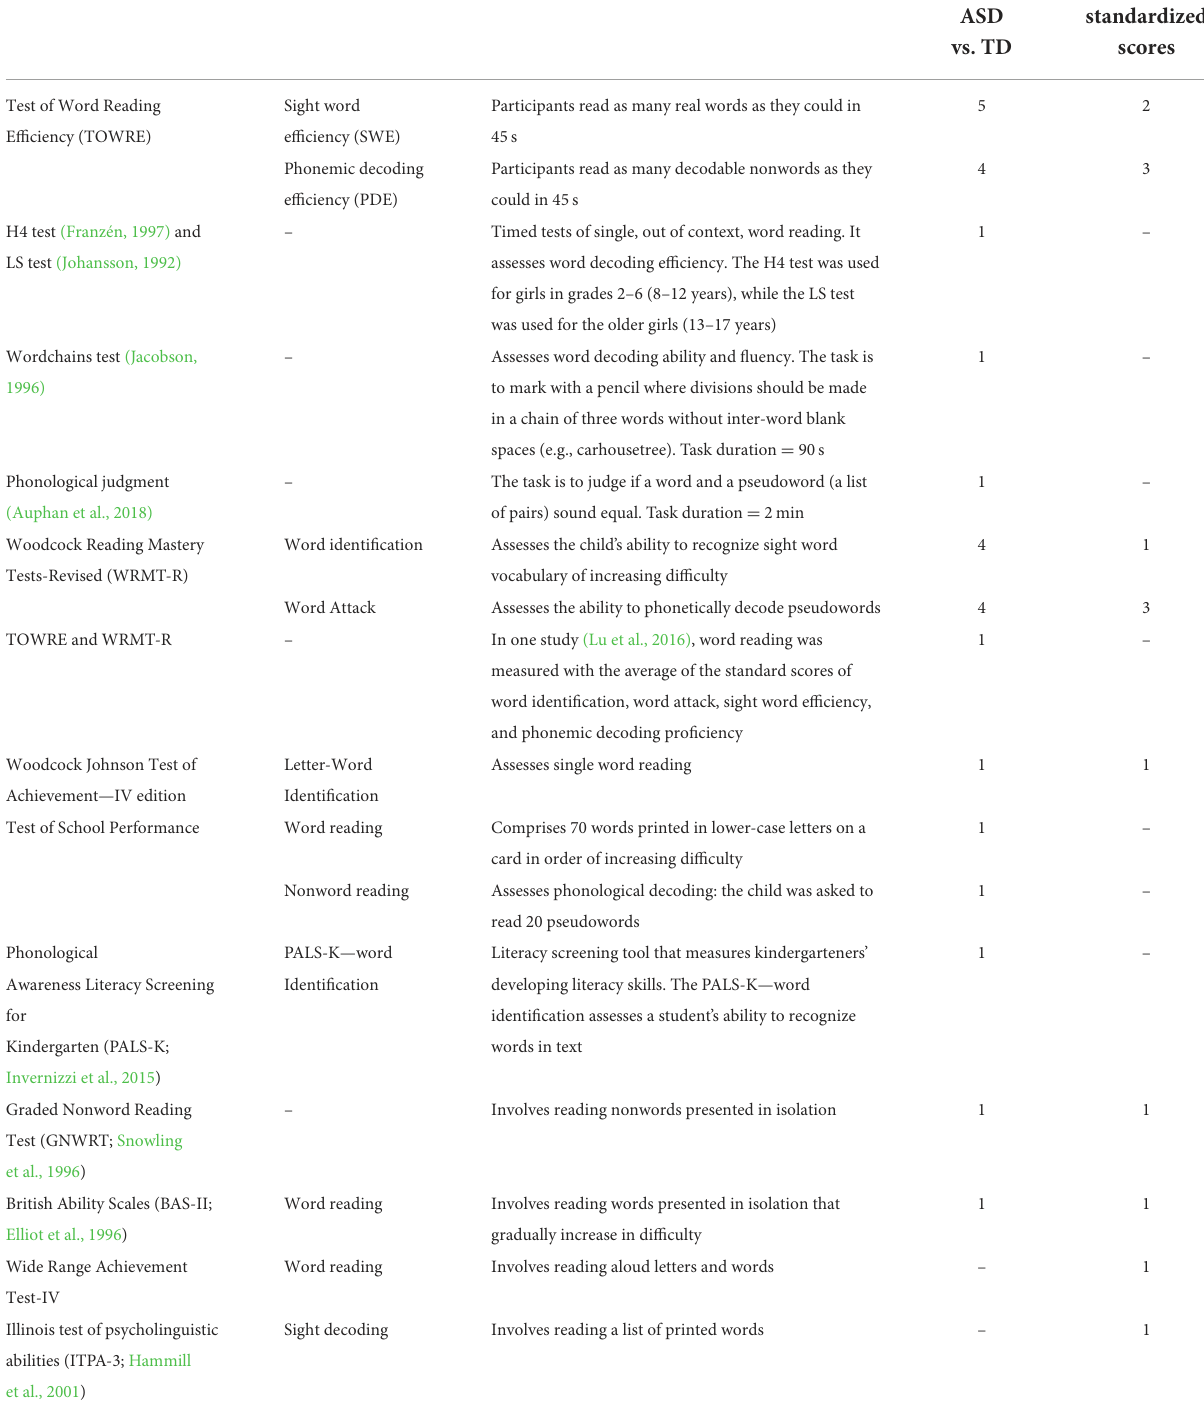
TABLE 1 Description of the tests included in this review and the number of comparisons ( N ) in which they were